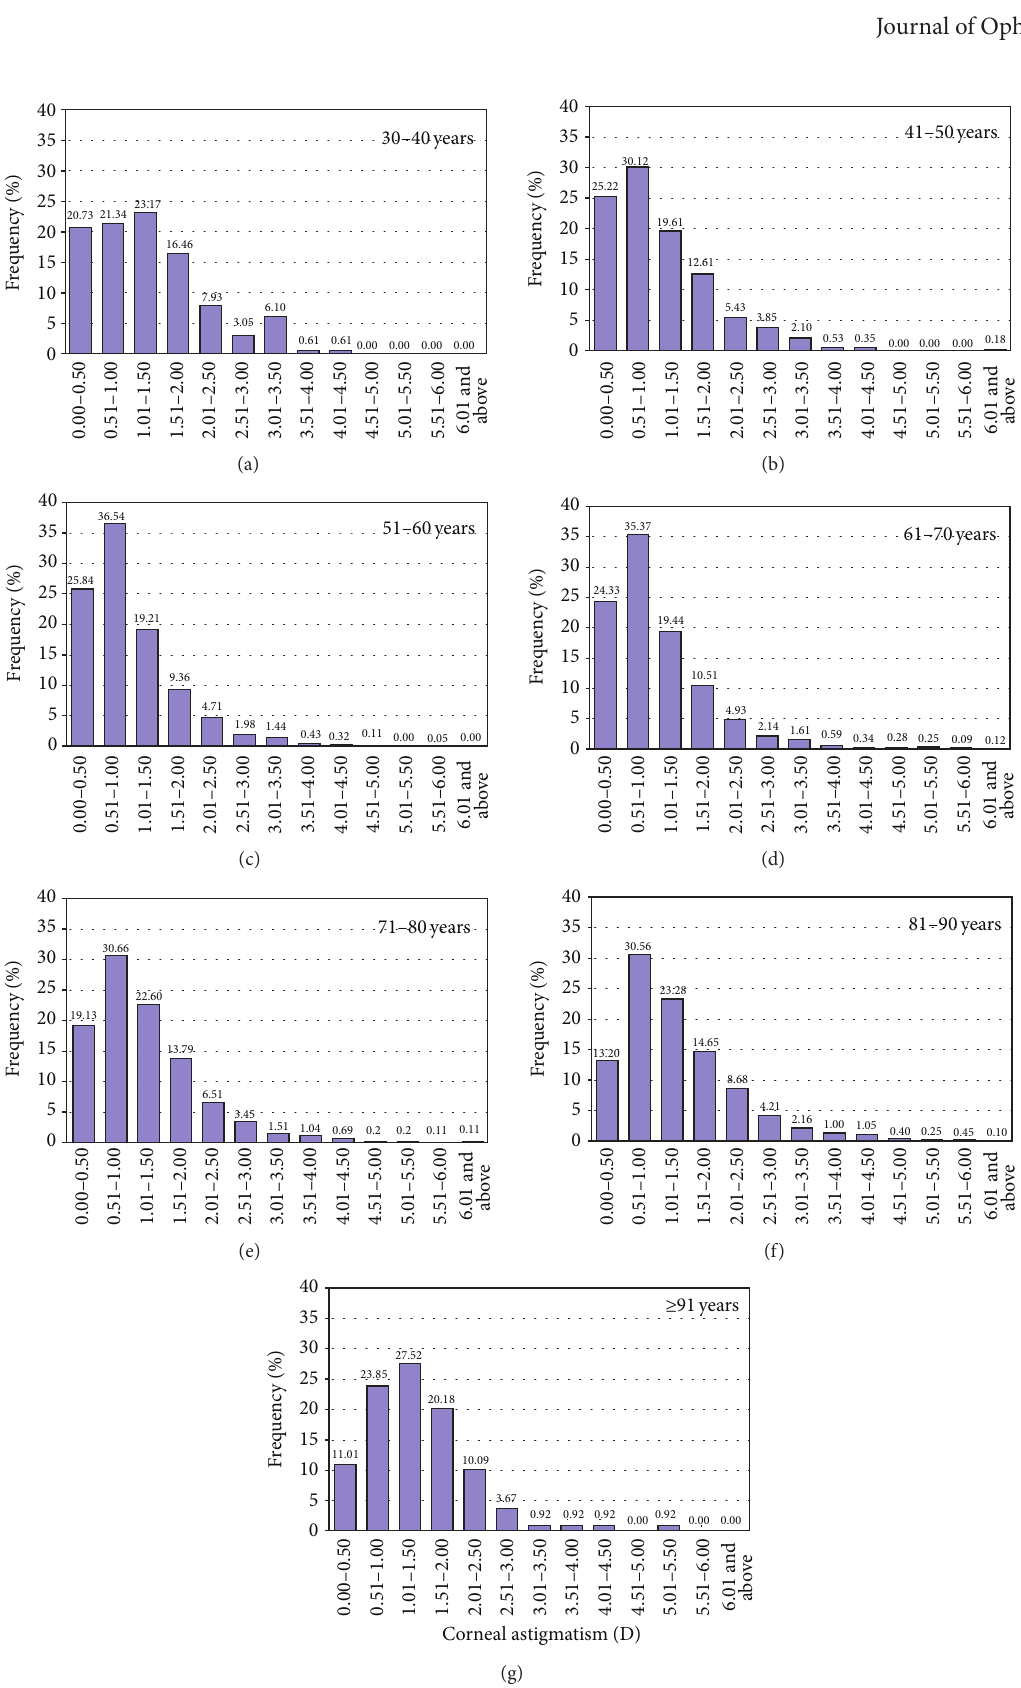
Figure 3: Frequency distribution of corneal astigmatism in 0.50 D steps for the 7 age